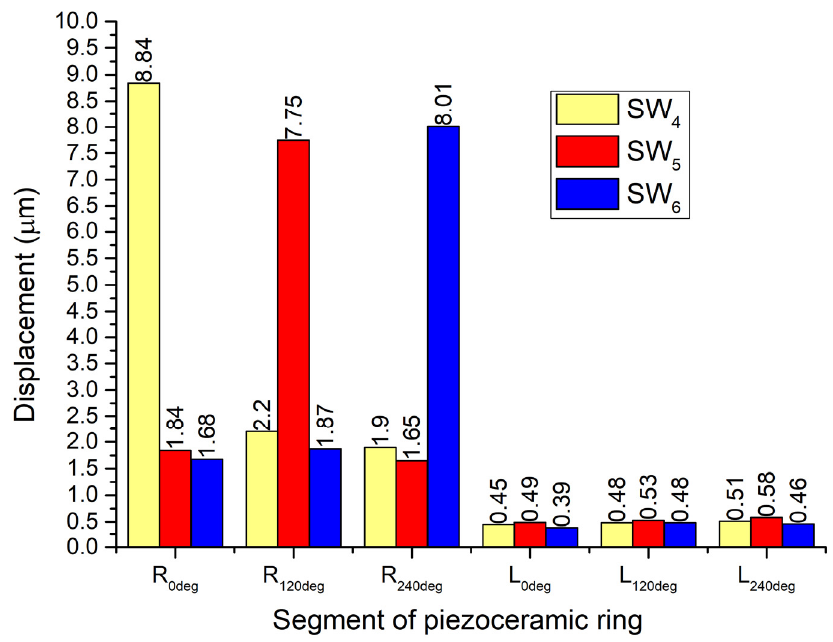
Figure 10. Comparison of displacement amplitudes when voltage is applied to segments R 0deg –R 240deg of the piezo ceramic ring.